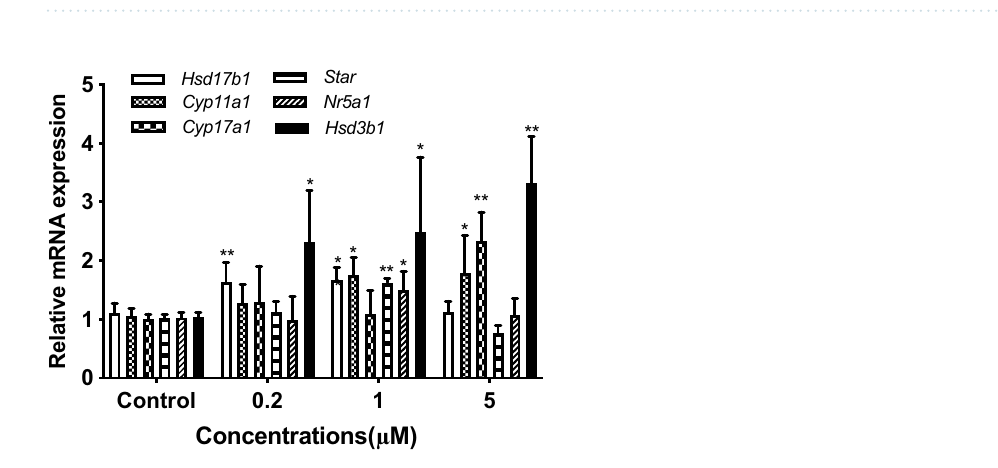
Figure 2. Effects of β-cyclodextrin–curcumin and curcumin on testosterone secretion in Leydig cells. ** P < 0.01 respect to Control.